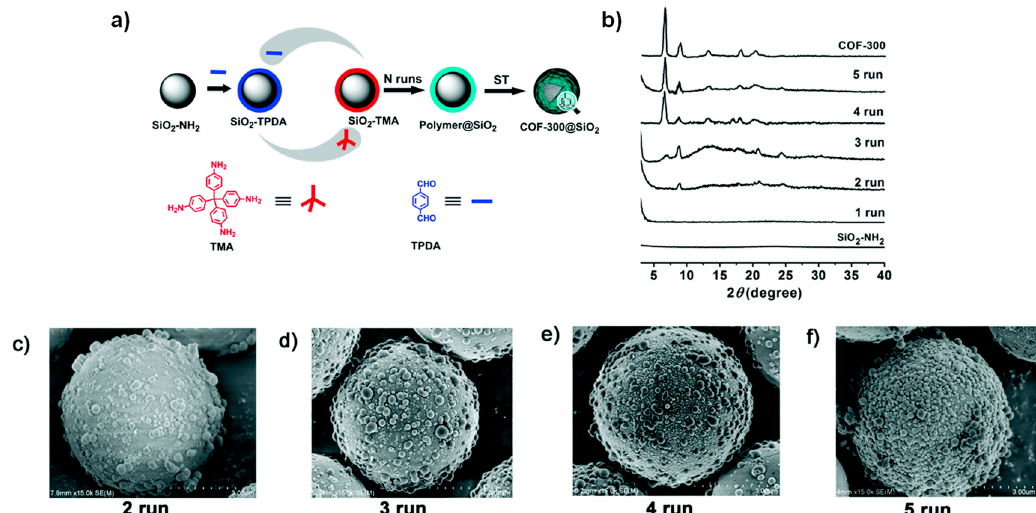
Figure 5. ( a ) Schematic illustration of the synthesis of COF-300@SiO 2 via LBL method; ( b ) powder XRD patterns of COF-300@SiO 2 after different reaction runs; ( c − f ) SEM images of COF-300@SiO 2 after ( c ) 2, ( d ) 3, ( e ) 4, and ( f ) 5 runs. Reproduced from [40] with permission from The Royal Society of